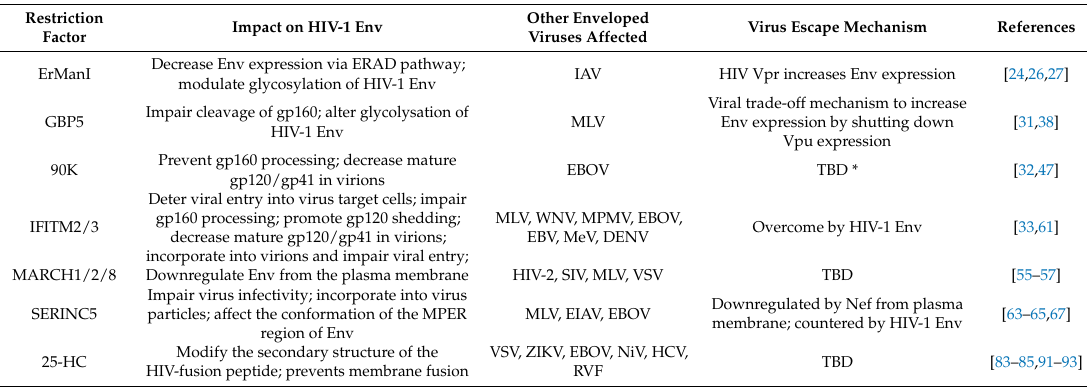
Table 1. Summary of the restriction factors that target HIV-1